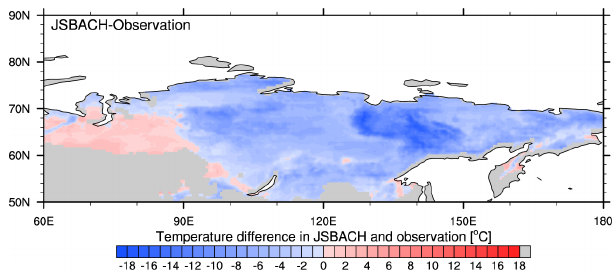
Fig. 12. Difference of simulated and observed permafrost tempera- tures (map b − a from Fig. 11).